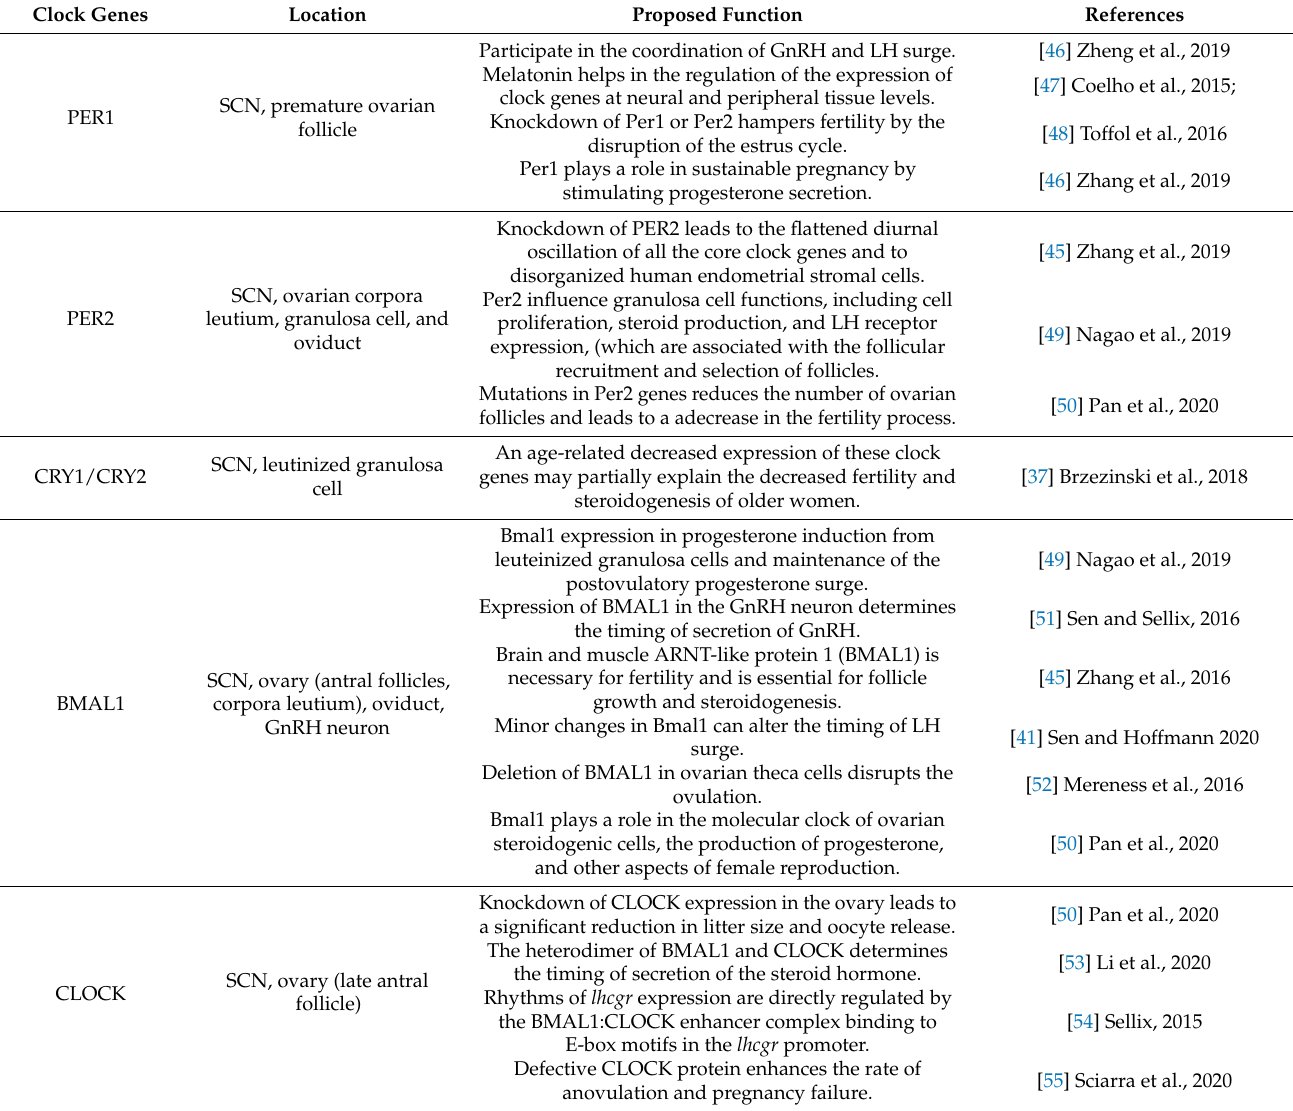
Table 1. Summary of clock genes’ location and the proposed mechanisms of the effects on mammalian reproduction. Clock